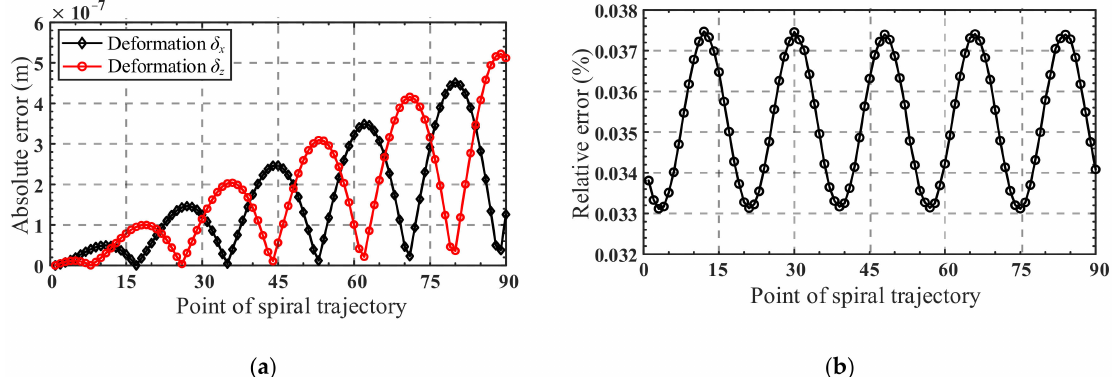
Figure 13. ( a ) Absolute errors of displacements δ x and δ z , during spiral trajectory; ( b ) relative errors in percentage, between analytical and FE-results for both trajectories during the spiral